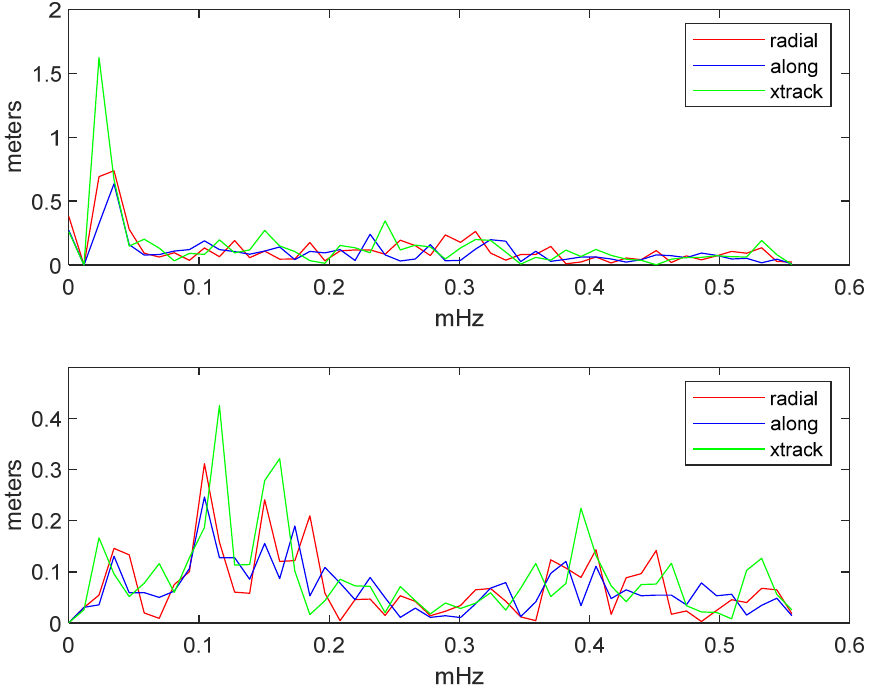
Figure 16. Spectrum of the pre-fit (top) and post-fit (bottom) residuals of the coordinates of the Glonass satellites relative to the CNES precise ephemeris, projected on the radial, tangential and across track basis. Average values for January